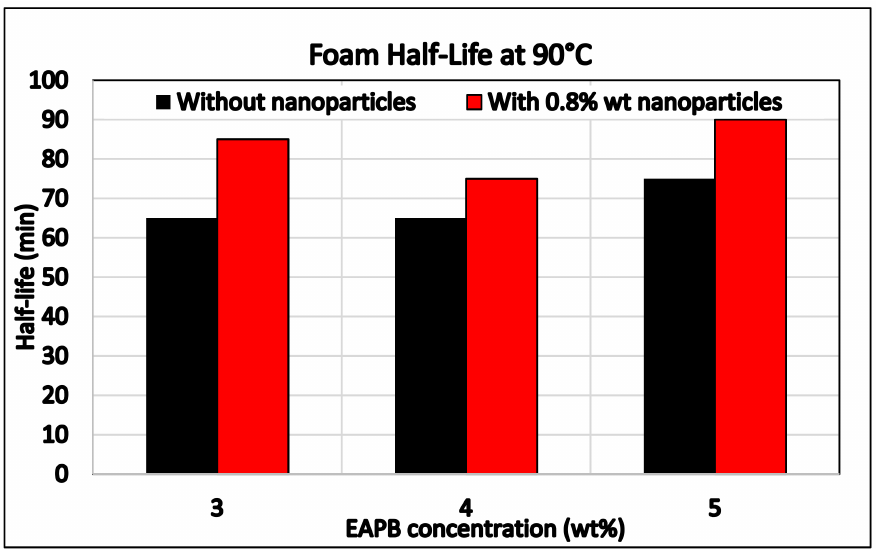
Figure 24. Free drainage half-life of foam under high temperature (Recreated with permission from Fei et al. [39]). Copyright 2017, The Korean Society of Industrial and Engineering Chemistry. Published by Elsevier B.V.